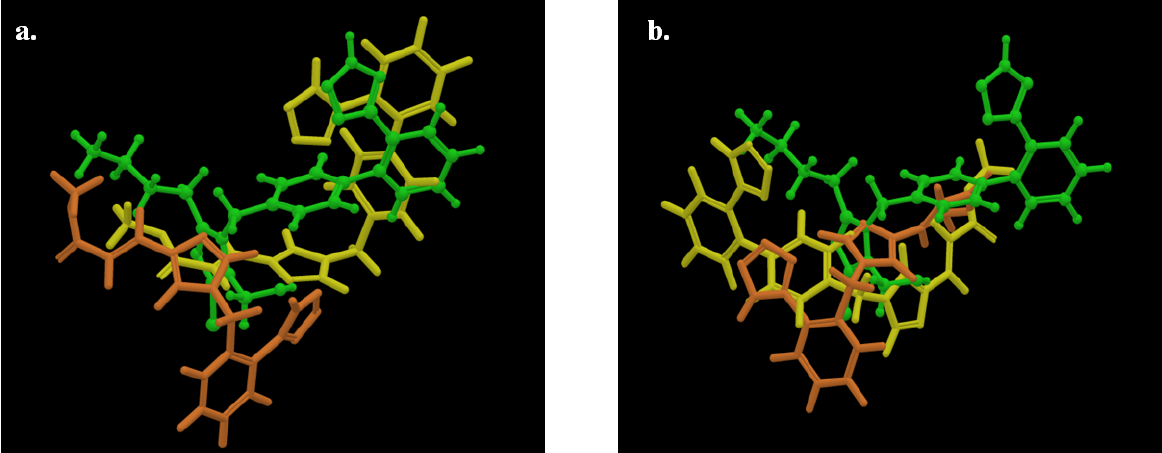
Figure 2. a. Superimposition of losartan (green), with low scoring orientations of analogues 12 (orange) and 18 (yellow). b. with the highest scoring